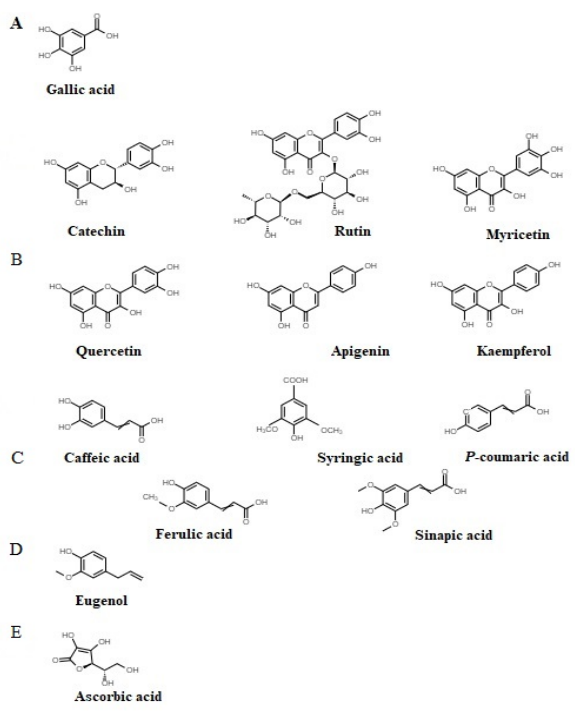
Figure 1. Chemical structures of tannin ( A ), flavonoid ( B ), cinnamic acid ( C ), essential oil ( D ), and vitamin C ( E ).